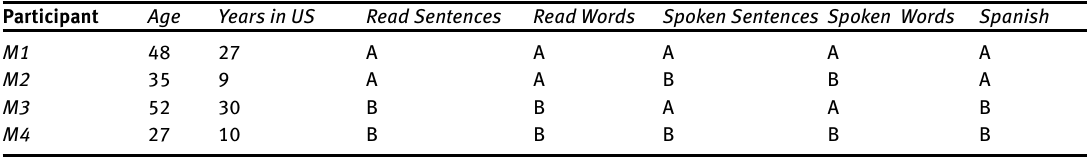
Table 3. Biographic details of talkers, and stimulus